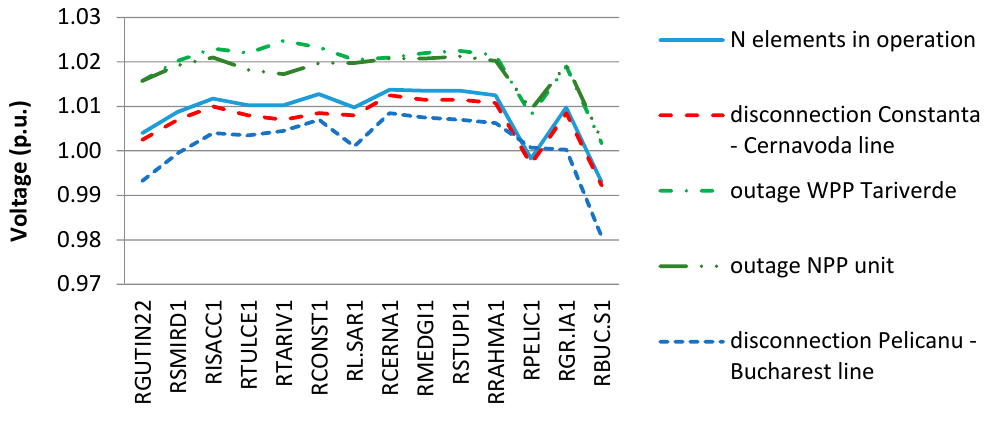
Figure 5. Voltage variation at 400 kV buses (p.u.).